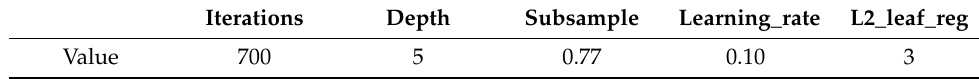
Table 8. Optimal values of key hyperparameters of CatBoost